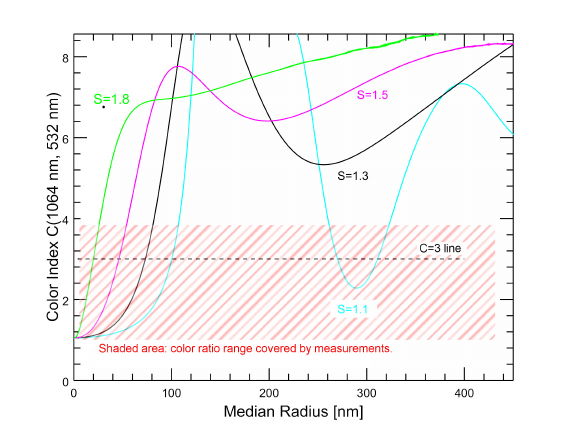
Figure 3. Radius dependence of the color index C for λ 1 = 1064nm and λ 2 = 532nm (see Equation (11)) calculated using a Mie scattering code for different distribution widths S (solid lines). The range of color ratios from monthly mean data of March 2013 is indicated by the shaded area. The horizontal black dashed line indicates a color index value of C =